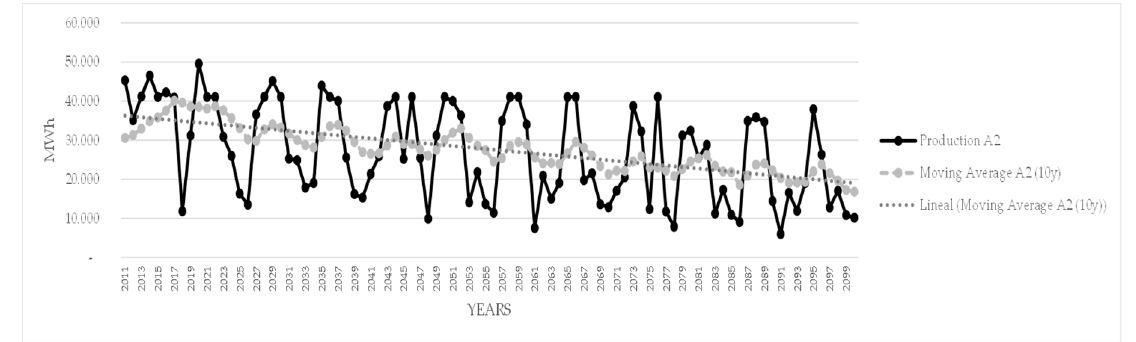
Figure 7. Projected production at Mengibar in MWh (A2). Energies 2017 , 10 , 1343